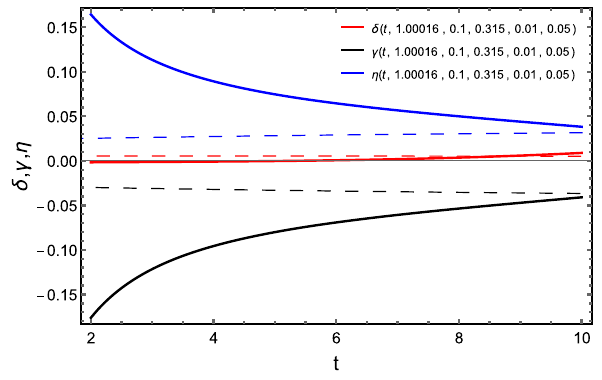
Fig. 5 DE skewness parameters vs.